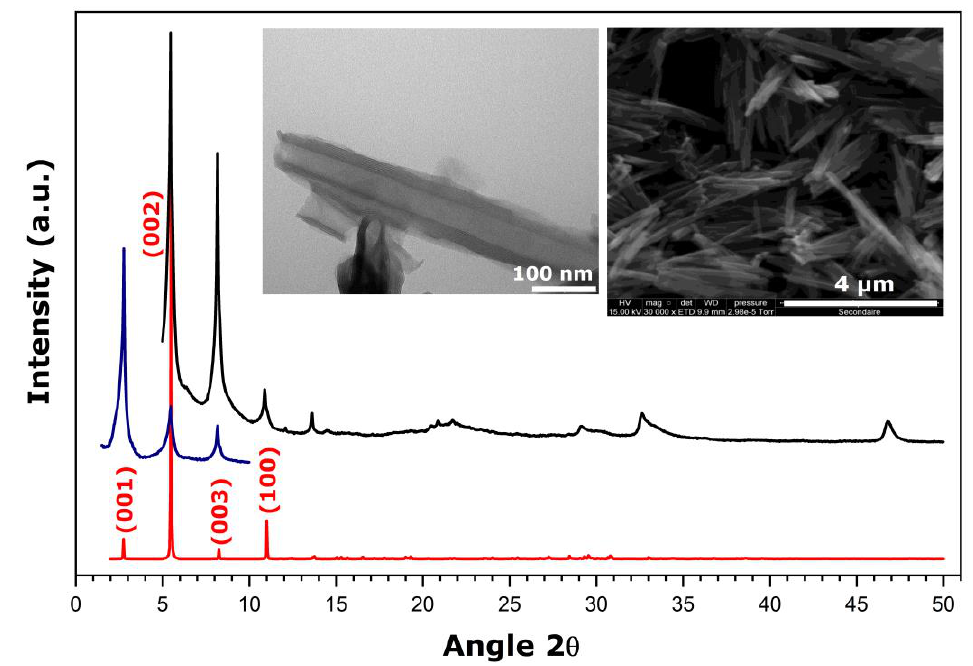
Figure 1. Theoretical XRD diffractogram simulated for a crystallographic structure without defects and a perfect stacking of the layers ( red line ) compared to room temperature wide-angle ( black line ) and small-angle ( blue line ) XRD patterns of the hybrid hexadecylamine-vanadium oxide material with a scroll-like morphology. The insets show TEM ( left panel ) and SEM ( right panel ) micrographs of the sample. This example corresponds to the sample prepared under synthesis conditions (right) detailed further in Table 2.